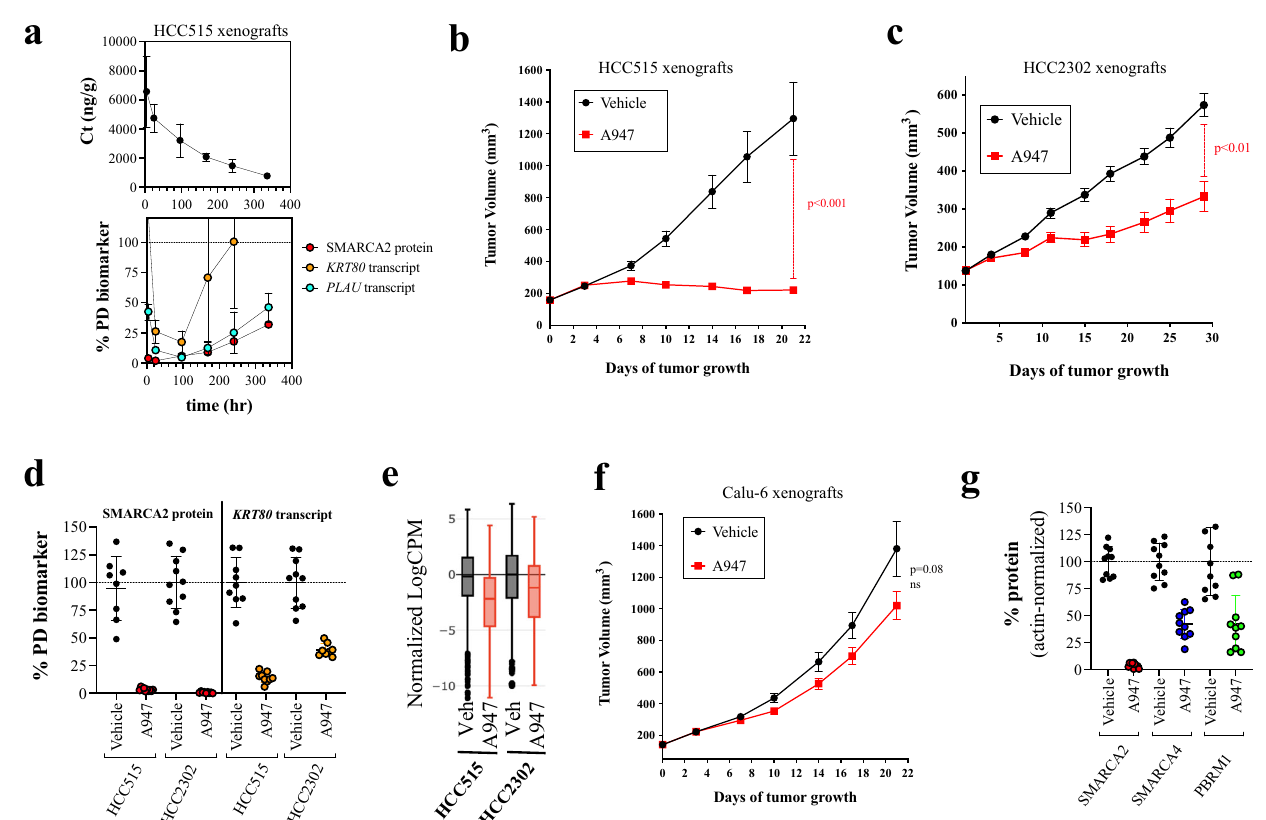
Fig. 4 | A947 is selectively ef fi cacious in SMARCA4-mutant NSCLC xenograft models.a Tumorconcentration(uppergraphic)andpharmacodynamicbiomarker responses (lower graphic) monitored over a 2 week period in HCC515 xenograft tumors following a single-dose, intravenous (i.v.) administration of A947 (40mg/ kg).Tumorlevels of SMARCA2proteinwerequanti fi edbyImageLab from Western blots and normalized to a loading control protein ( β -actin). Tumor levels of the mRNA transcripts, KRT80 and PLAU , were quanti fi ed by Taqman. Data are pre- sented relative to levels in untreated tumors and represented as mean±s.d from n =5animalspertimepoint. b , c TumorvolumeinmiceharboringeitherSMARCA4- mutant HCC515 ( b ) or HCC2302 ( c ) xenografts following administration of A947 (40mg/kg,i.v.)orvehiclecontrol.Dataarepresentedasmean±s.e.m.( n =10mice/ group).Statisticalsigni fi cancewasassessedbyatwo-sided,unpairedStudent t test. p =0.0002; p =0.0049( c ). d Pharmacodynamicbiomarkerlevelstumorscollected at end of study from animals treated in ( b and c ) (SMARCA4 protein: HCC515- vehicle ( n =8), HCC515-A947 ( n =10), HCC2302-vehicle ( n =10), HCC2302-A947 ( n =9); KRT80 transcript: HCC515-vehicle ( n =9), HCC515-A947 ( n =9), HCC2302- vehicle( n =10),HCC2302-A947( n =8).Micereceiveda fi